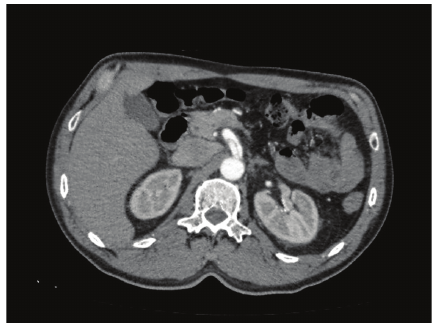
Figure 2: Computed tomography angiogram (axial view) revealing the double-barrel sign of the dissected superior mesenteric